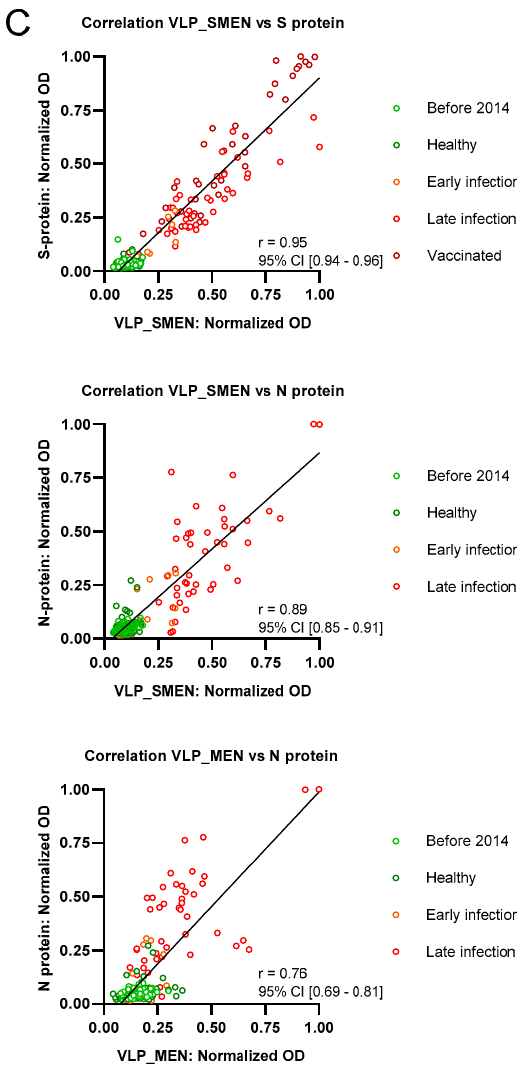
Figure 2. Serological characterization of 230 samples. ( A ) Classification of samples. ( B ) An in-house ELISA was used to assess the reactivity of the serum with VLP_SMEN, VLP_MEN, S- and N- protein. ( C ) Correlation between normalized OD values of VLPs and S- and N-protein. * p < 0.05, ** p < 0.01 and **** p < 0.0001.